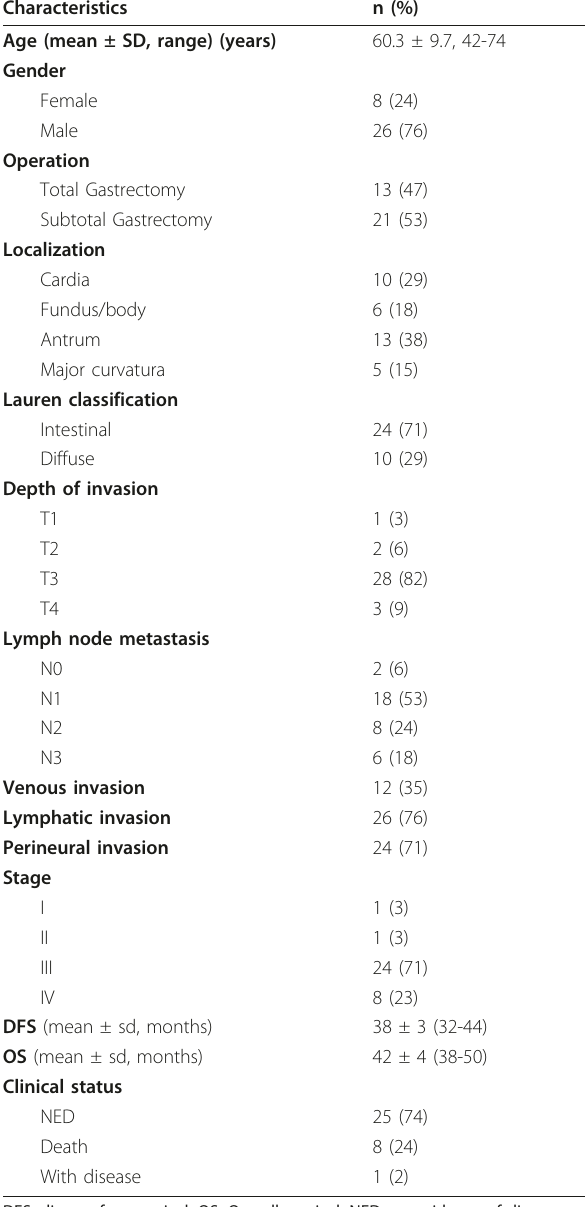
Table 1 Demographic characteristics of